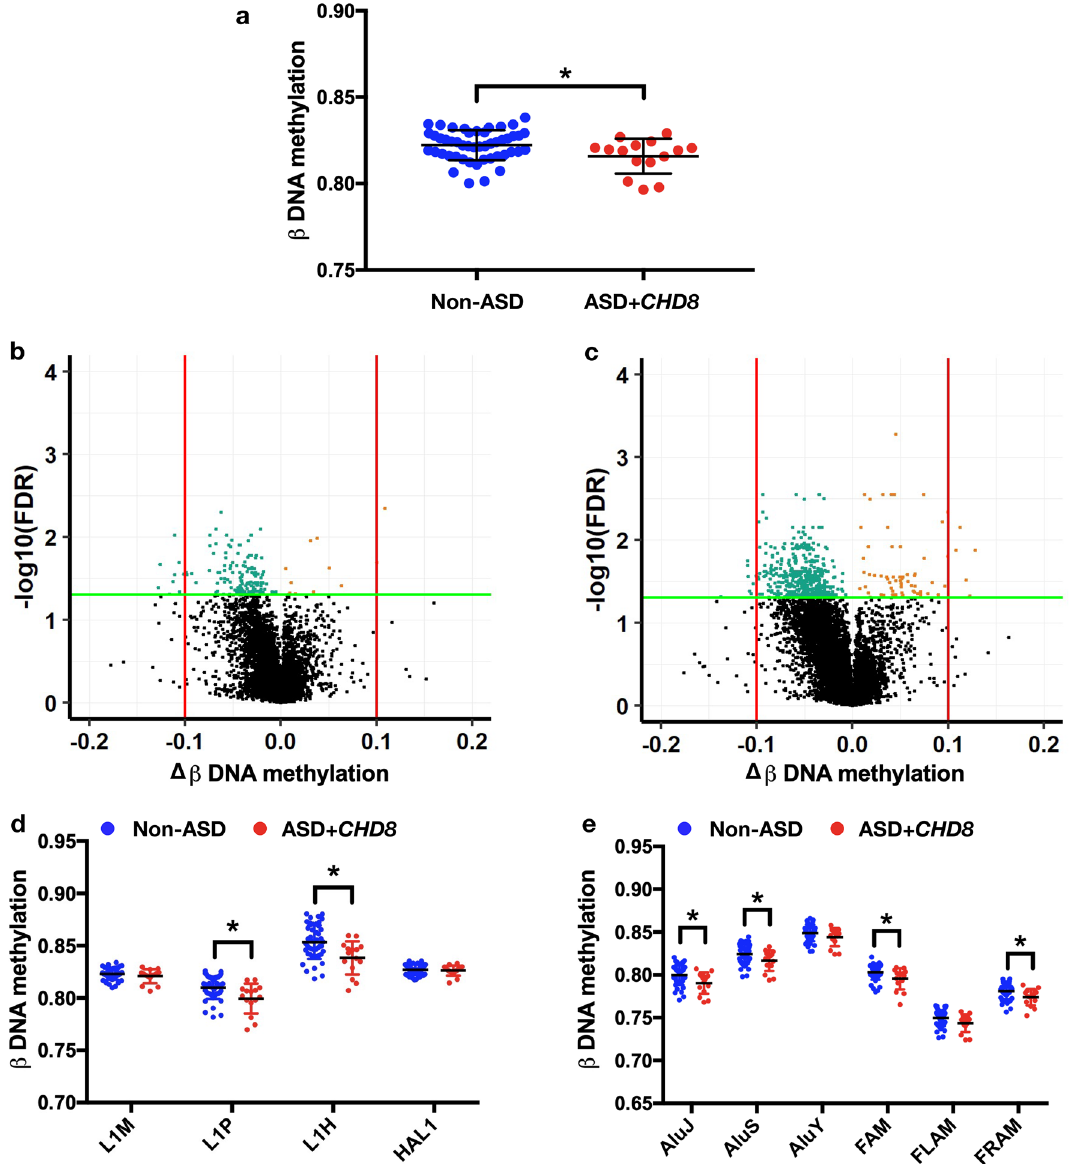
Figure 3. Methylation of repetitive elements (LINE-1 and Alu ) in non-ASD (n = 48) and ASD patients who carry CHD8 variants (n = 15). DNA methylation ( a ). Volcano plots of mean change in methylation (Δβ) of LINE-1 ( b ) and Alu ( c ) against − log10 FDR-adjusted p value (P FDR ) of ASD compared with non-ASD; the green line represents P FDR = 0.05, the red line represents 10% of methylation changes, green dots represent hypomethylation loci, and orange dots represent hypermethylation loci. Changes in DNA methylation (Δβ) of ASD with CHD8 compared with non-ASD by a subfamily of LINE-1 ( d ) and Alu ( e ). Mean ± SD. * p <